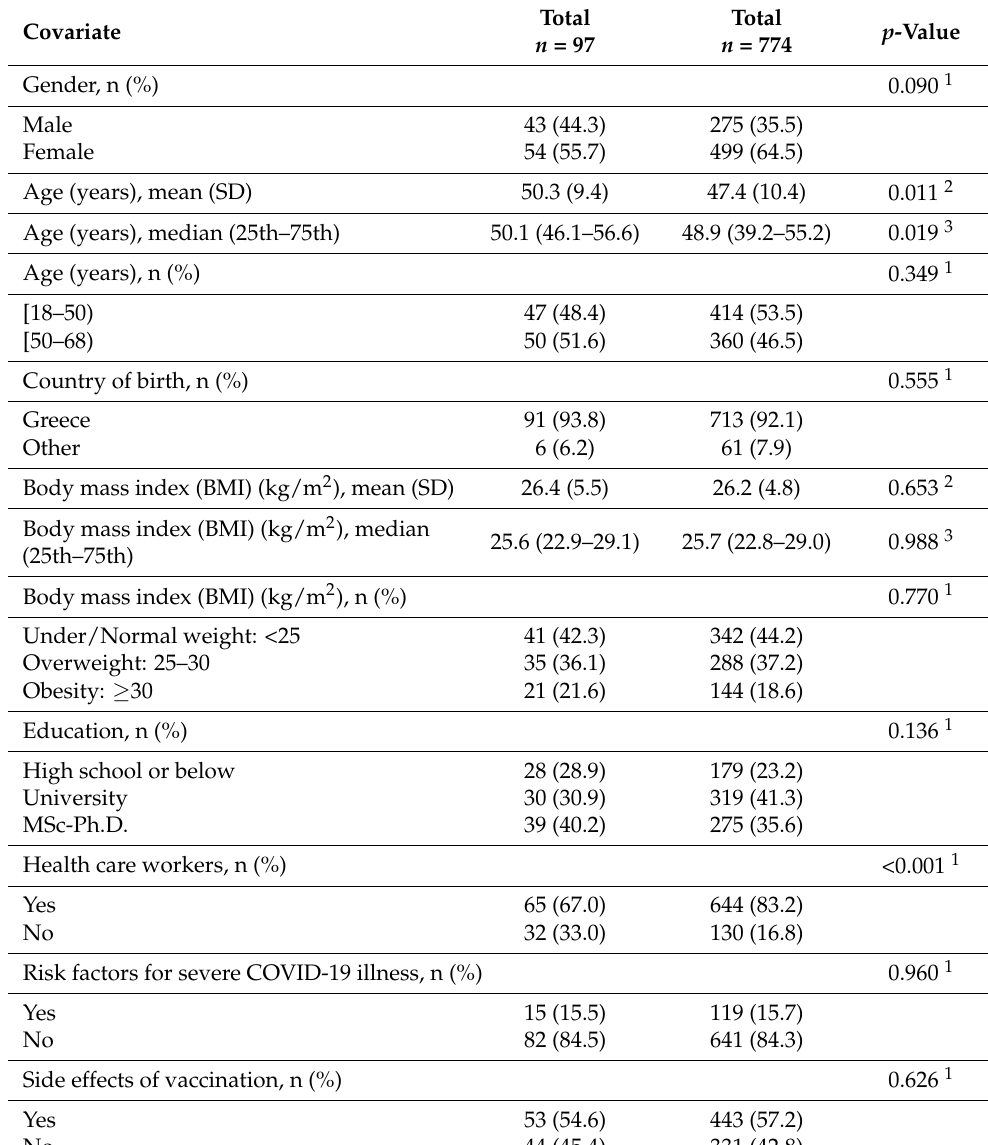
Table 1. Demographic and clinical characteristics of study